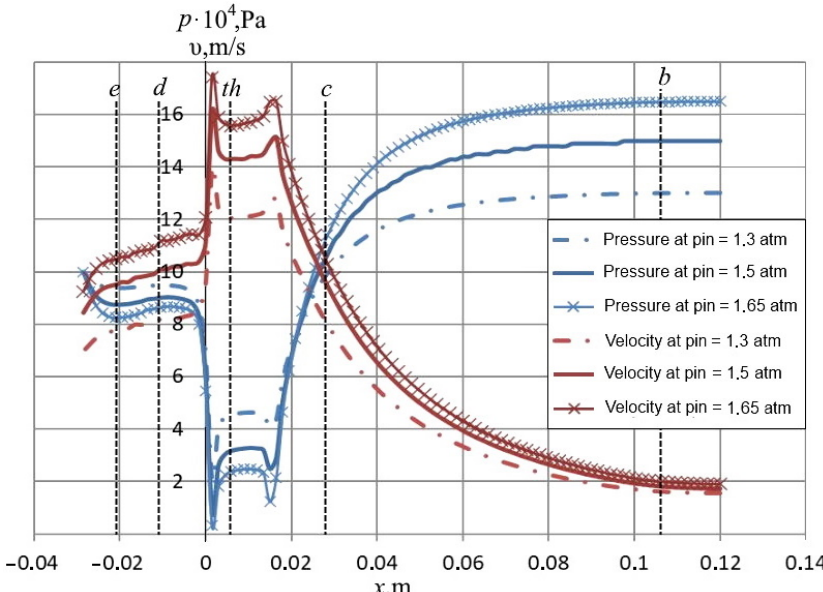
Figure 7. Absolute pressure p abs and flow velocity υ along inverted Venturi tube (from our CFD results).